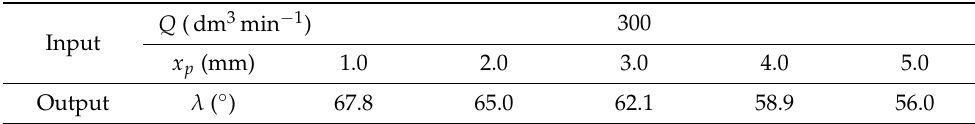
Figure 7. Results of CFD simulation for poppet position x p = 5.0 mm: ( a ) pressure distribution, ( b ) velocity distribution; λ = 56.0 ◦ . Table 4. Jet angle against poppet position from CFD